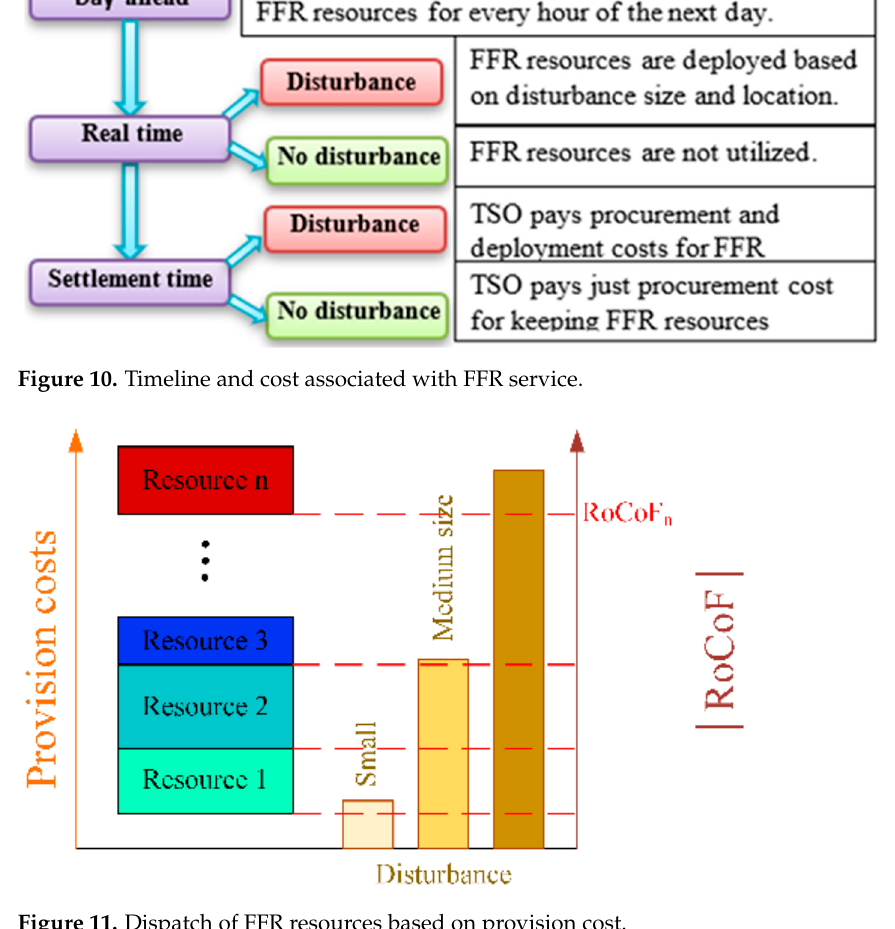
Figure 11. Dispatch of FFR resources based on provision cost.